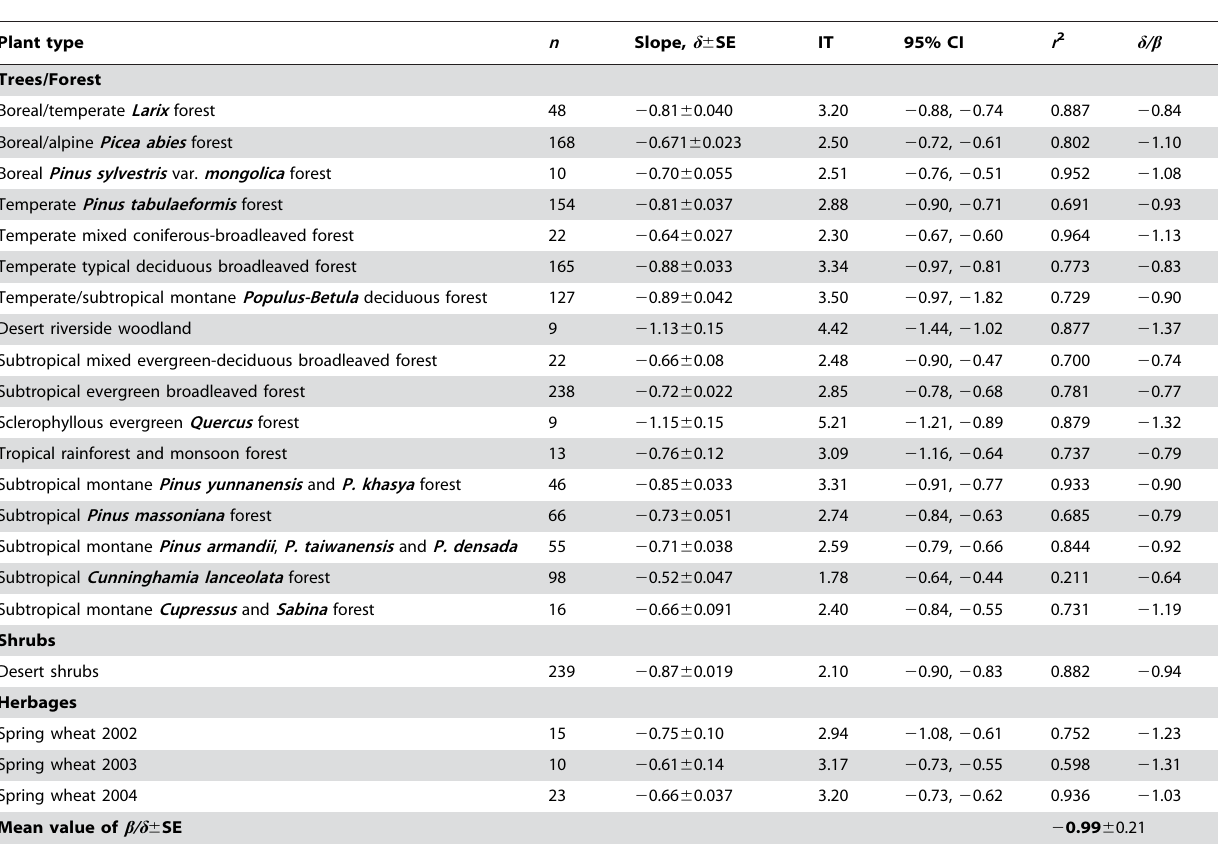
Table 2. The scaling relationship between population density, N , and body mass, M , and the ratio of the allometric exponent d to b for trees, desert shrubs and herbaceous plants.